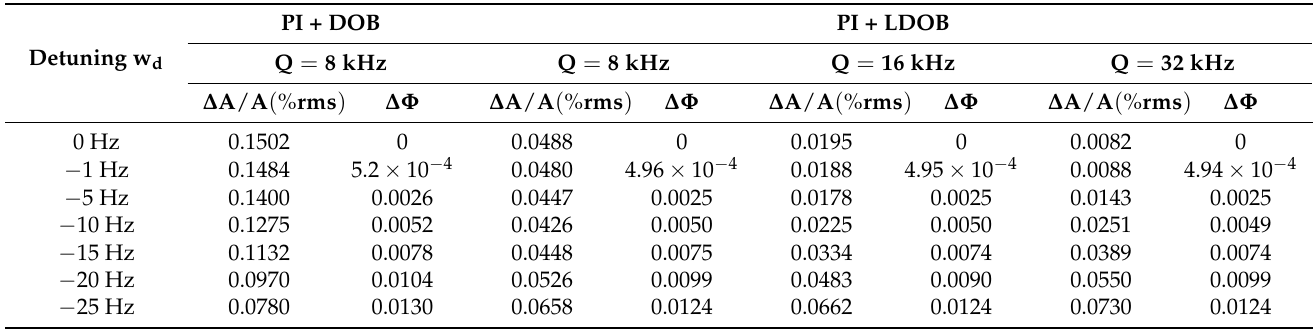
Figure 10. Control input for learning-based DOB + PI and conventional DOB + PI controllers. Table 3. Performance of conventional DOB and learning-based DOB in presence of beam loading and different cavity